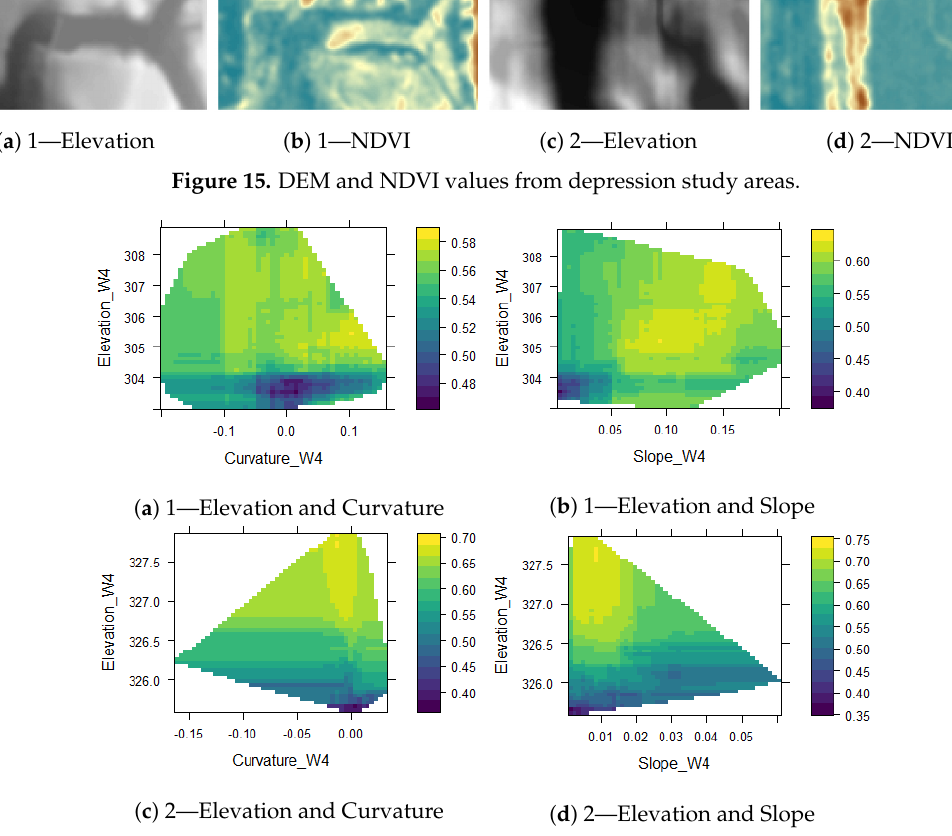
Figure 16. Partial Dependency Plots (PDPs) corresponding to depression study areas w.r.t.